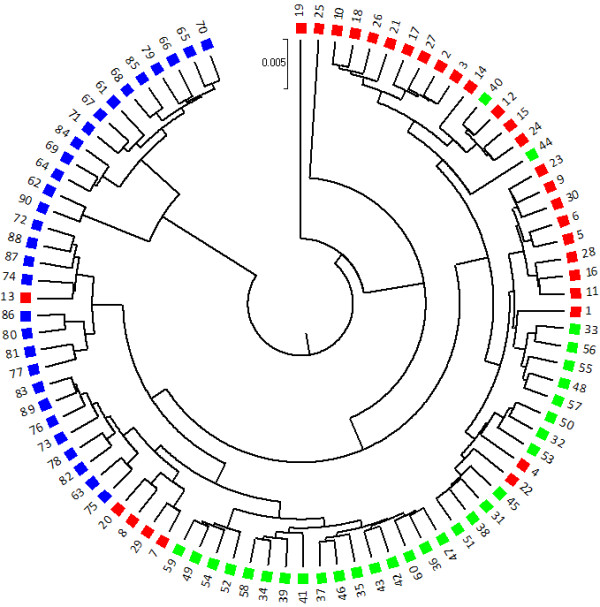
Metagenomic samples can be clustered well using dissimilarity measure d2S|M0. Example of a clustering of 90 samples in Simulation 1 obtained at sequencing depth = 10,000 reads per sample, with k = 6 and dissimilarity measure d2S|M0. The true clusters are labeled by three colors and symbols (red triangles, green squares and blue discs). The parsimony test score is 10 in this example with p-value less than 0.001.